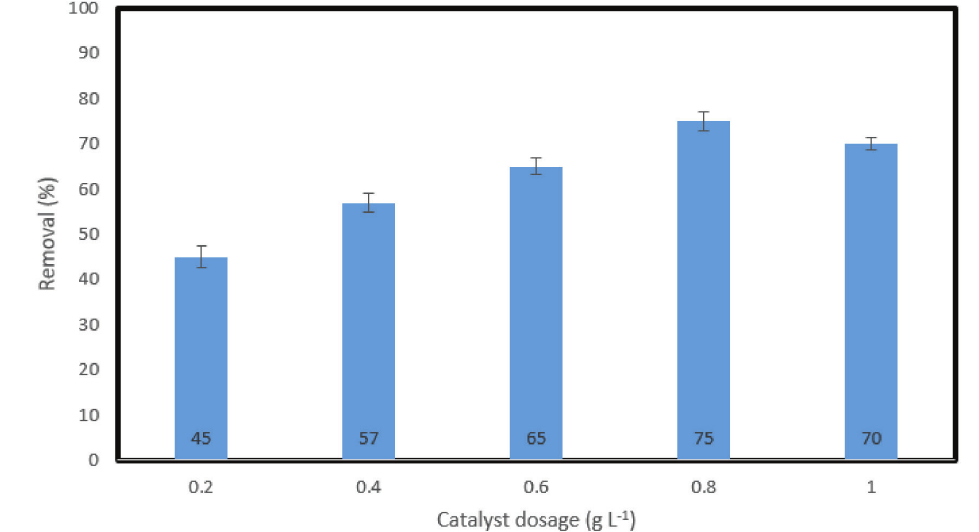
O concentration of 2 2